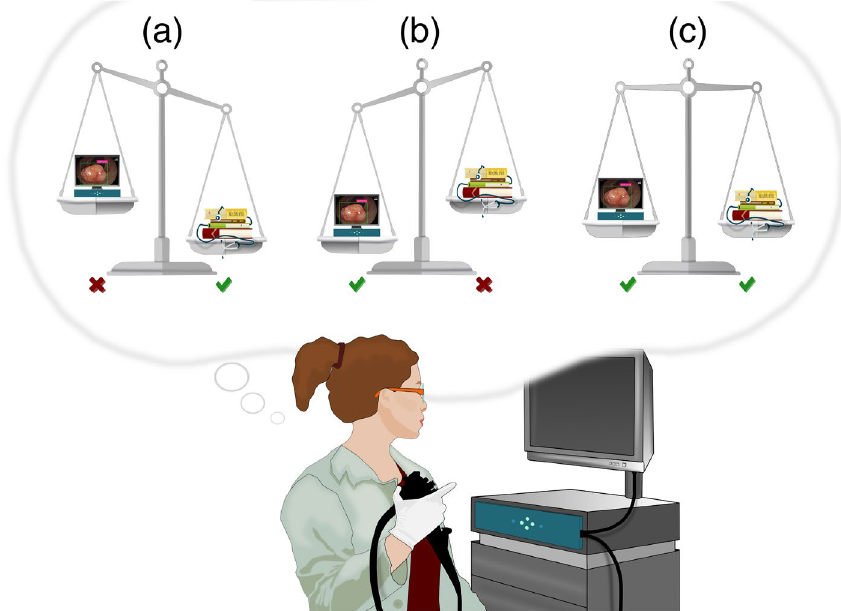
Figure 2. md-ai team. An endoscopist subject to under-reliance discounts the added information given by the ai ( a ). An endoscopist subject to over-reliance supinely accepts the ai suggestion ( b ). The optimal use of ai should rest on an in-between, well-calibrated approach where the endoscopist uses the ai opinion for coherently revising their confidence in their initial evaluation. In this way, the medical decision-making process would benefit from a collaboration between the two intelligences ( c